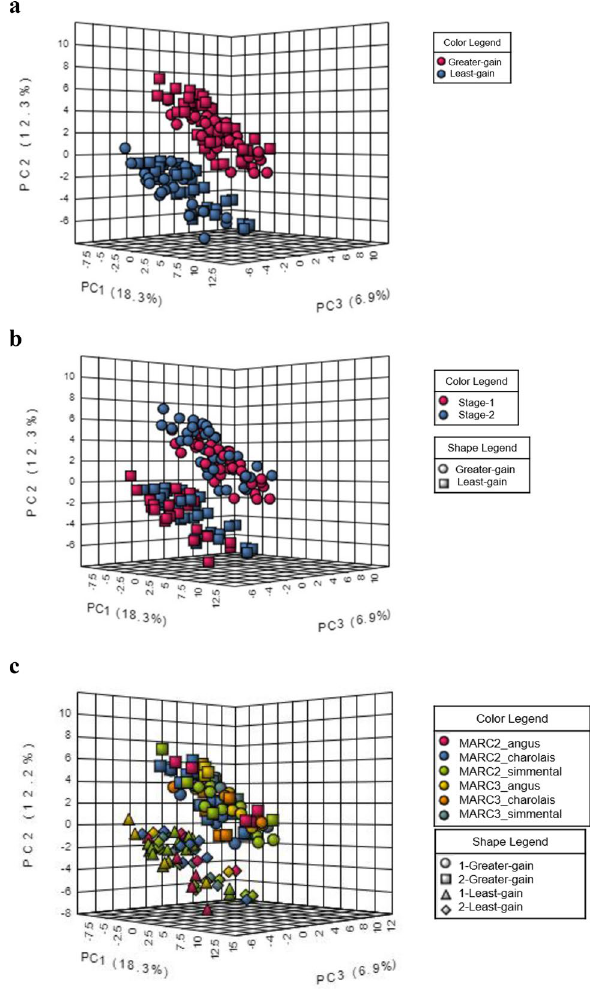
Figure 4. Interactive principal components analysis (iPCA) of untargeted metabolites of selected least-ADG vs. greater-ADG classification steers ( a ), and interactions with both stages ( b ) and, breed type ( c